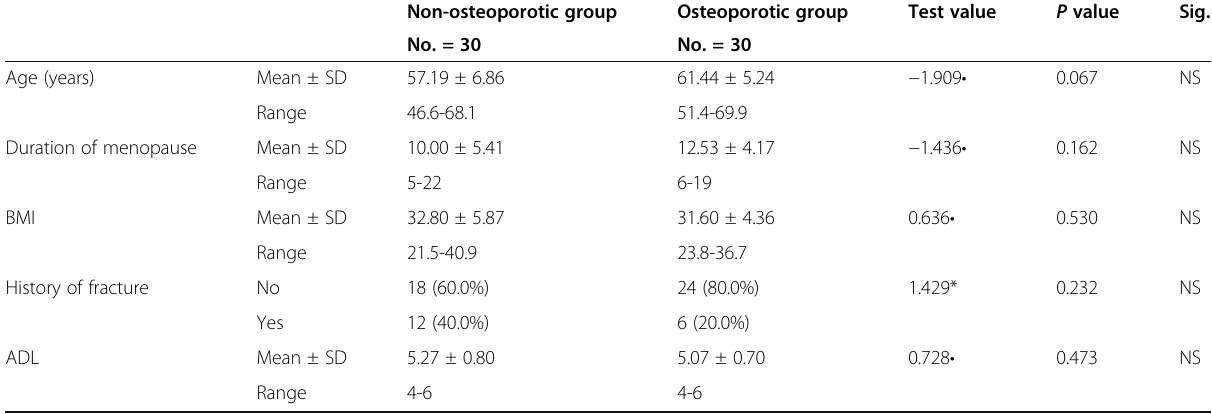
Table 1 Comparison between osteoporotic group and non-osteoporotic group regarding demographic